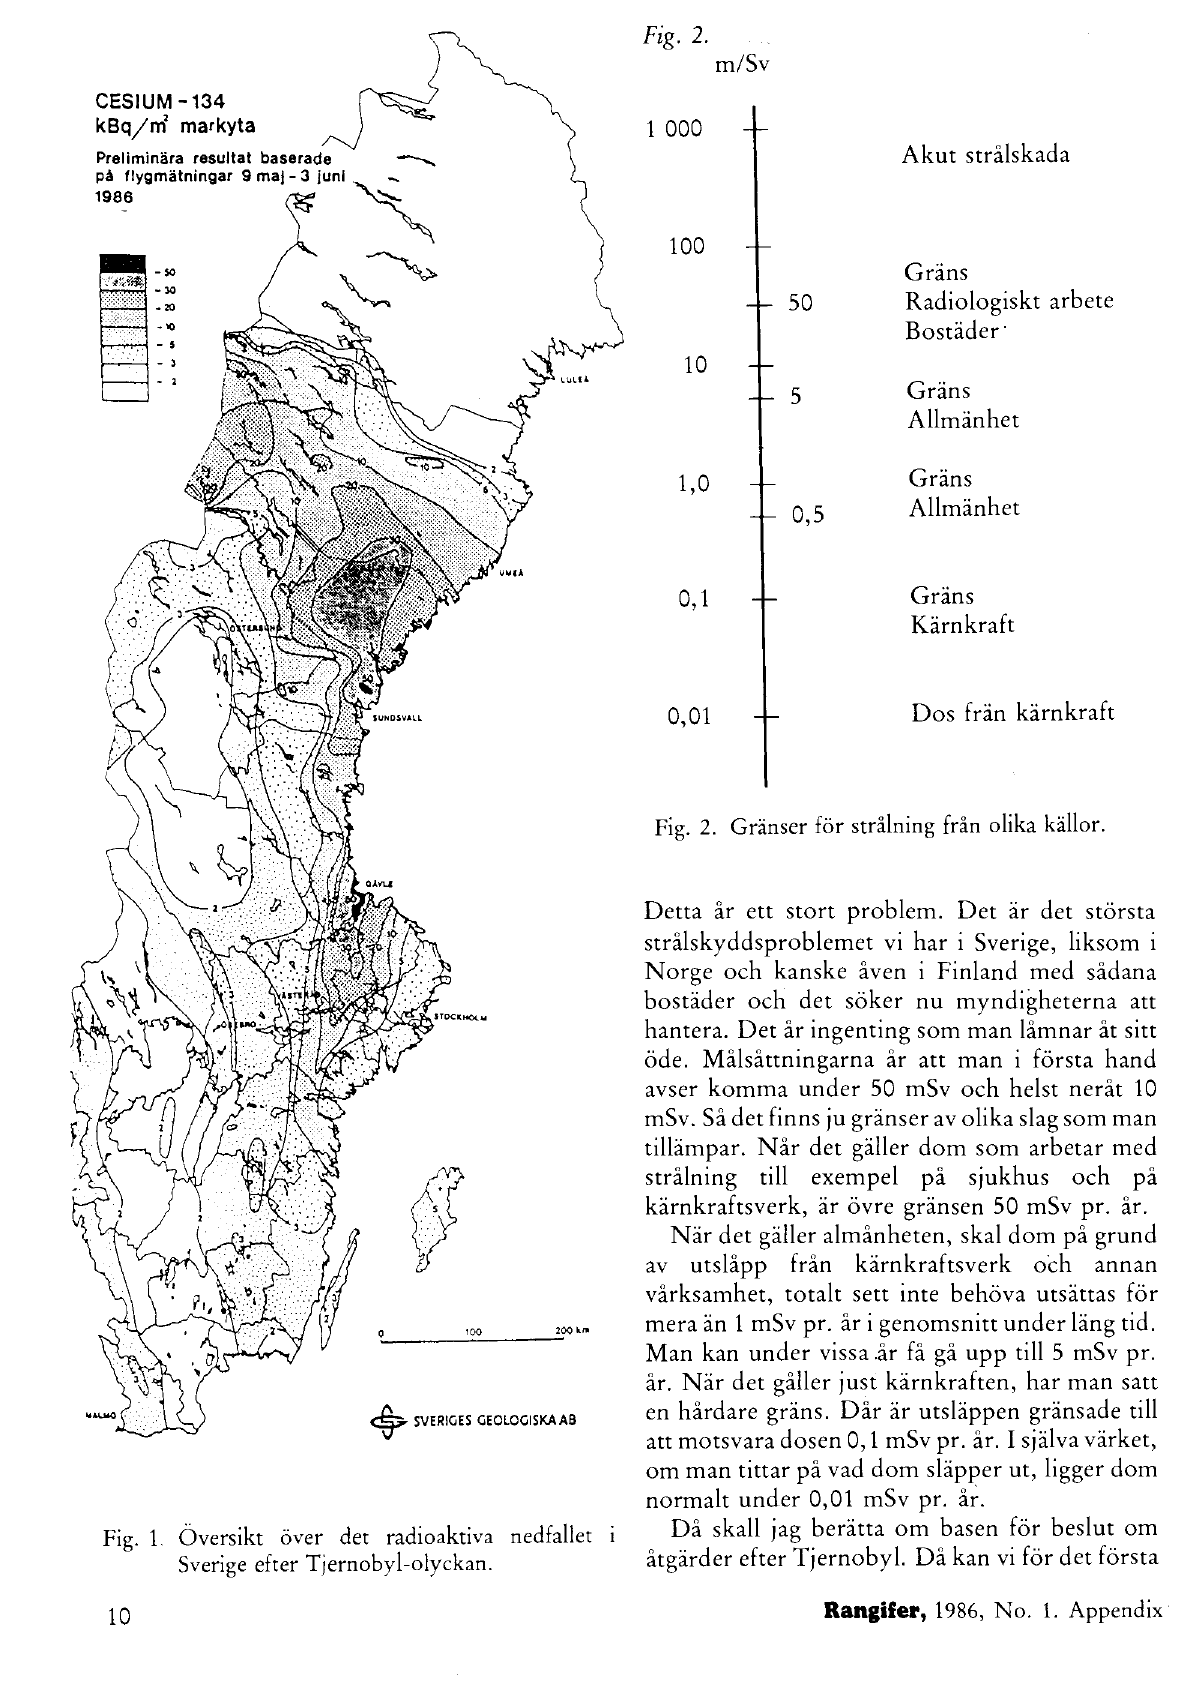
Fig. 1. Oversikt over det radioaktiva nedfallet Sverige efter Tjernobyl-olyckan.